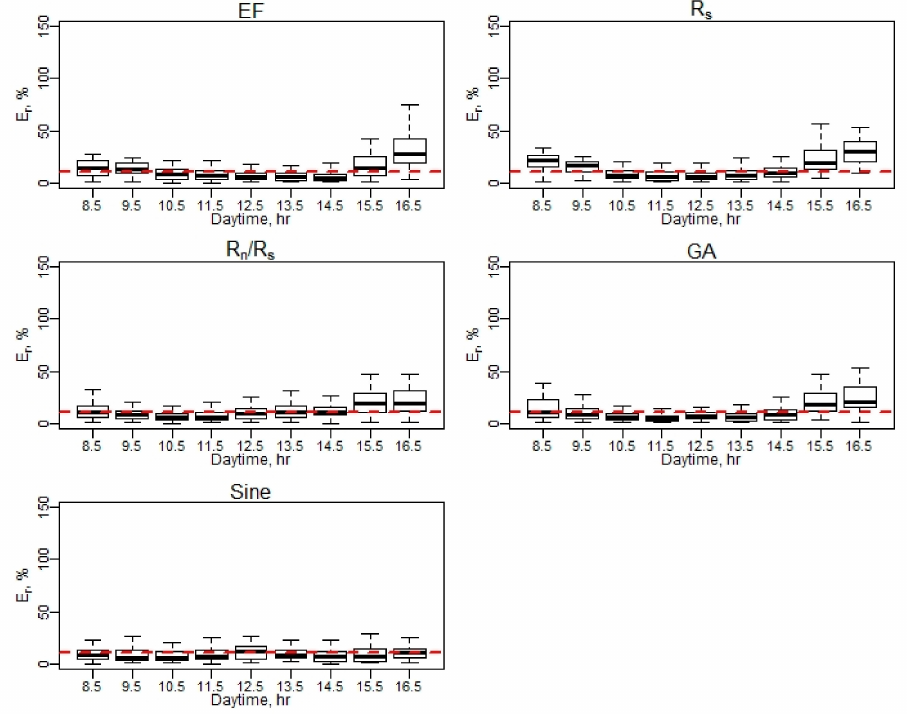
Figure A15. E r of daily EC ET (April–May).